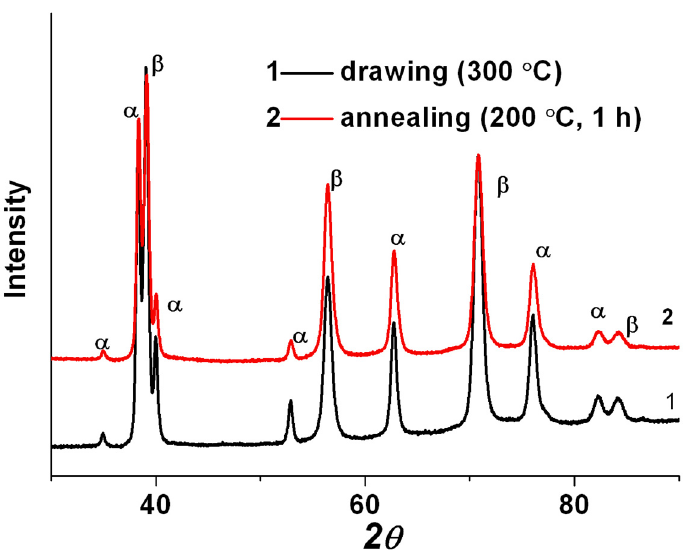
Figure 7. XRD patterns of the Ti-15Mo alloy after drawing and stress-relief annealing at 200 °C for 1 h.